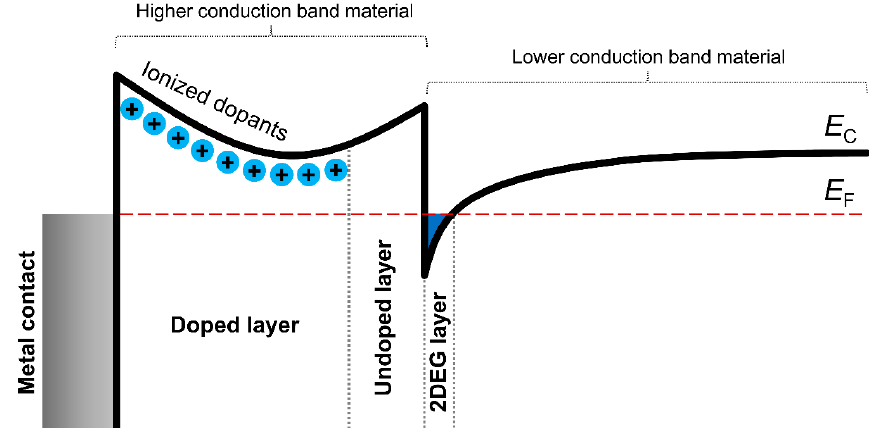
Figure 4. Principle of modulation doping to obtain a high-mobility 2DEG according Ref. [74].